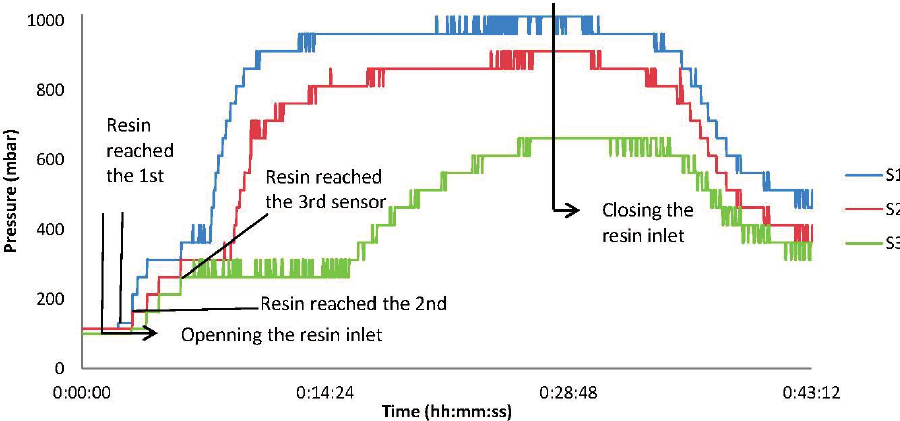
Figure 11. Real-time pressure profiles inside the fiber composite laminate at infusion